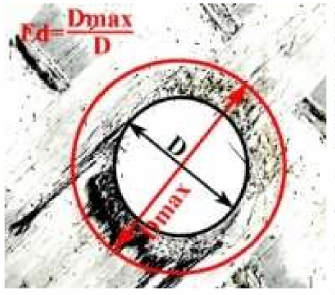
Figure 5. Delamination